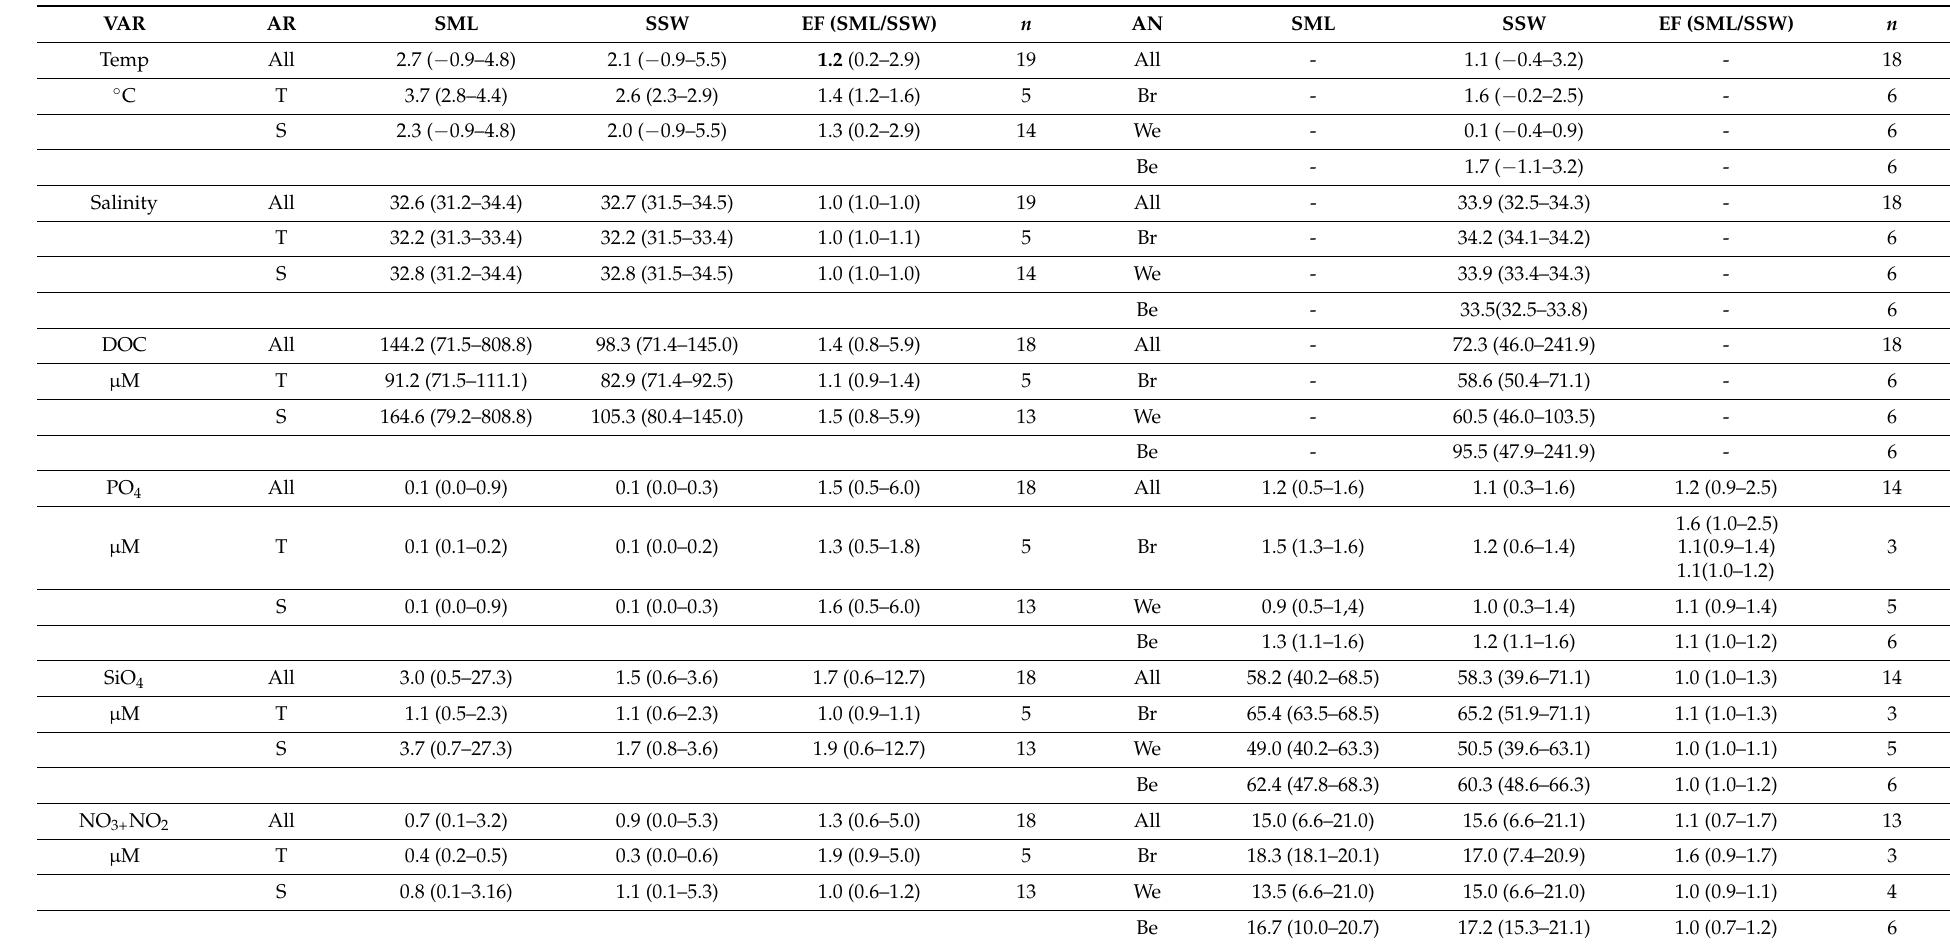
Table 1. Mean, minimal, and maximal values of physicochemical variables (VAR) of the surface microlayer (SML) and subsurface water (SSW) from Arctic (AR; T: transect; S: Svalbard; ATOS 1) and Antarctic (AN; Br: Bransfield; We: Weddell; Be: Bellingshausen; ATOS2) seawaters. EF: enrichment factor, in bold significant values ( p < 0.05) different than 1. Temp: temperature; DOC: dissolved organic carbon; PO 4 , SiO 4 , NO 3 +NO 2 , and NH 4 : inorganic nutrients; n : number of values; nd: non-detected; -: no data. Wind: wind speed (m s − 1 ) and UV